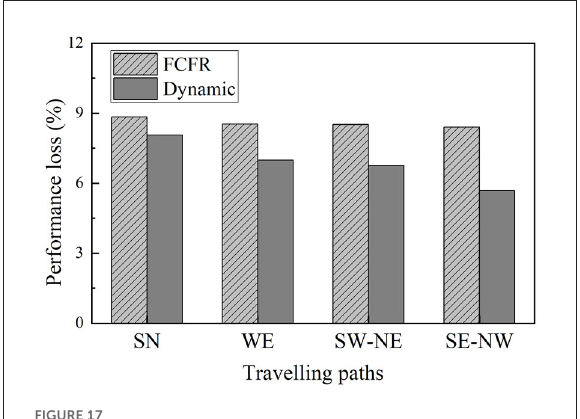
FIGURE17 Performance loss with different traveling paths and recovery